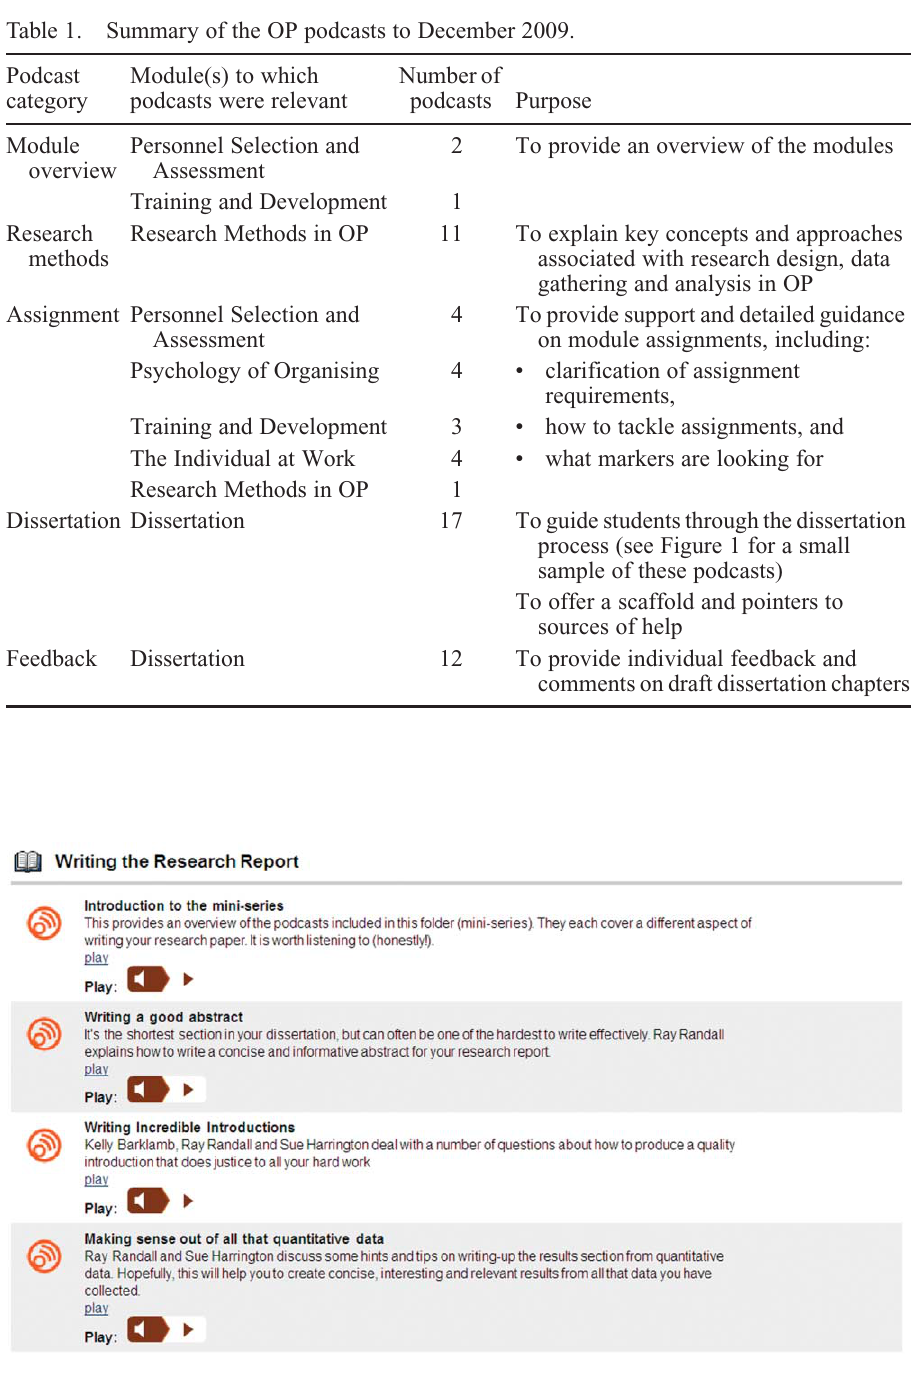
Figure 1. Sample podcasts to support the writing of the